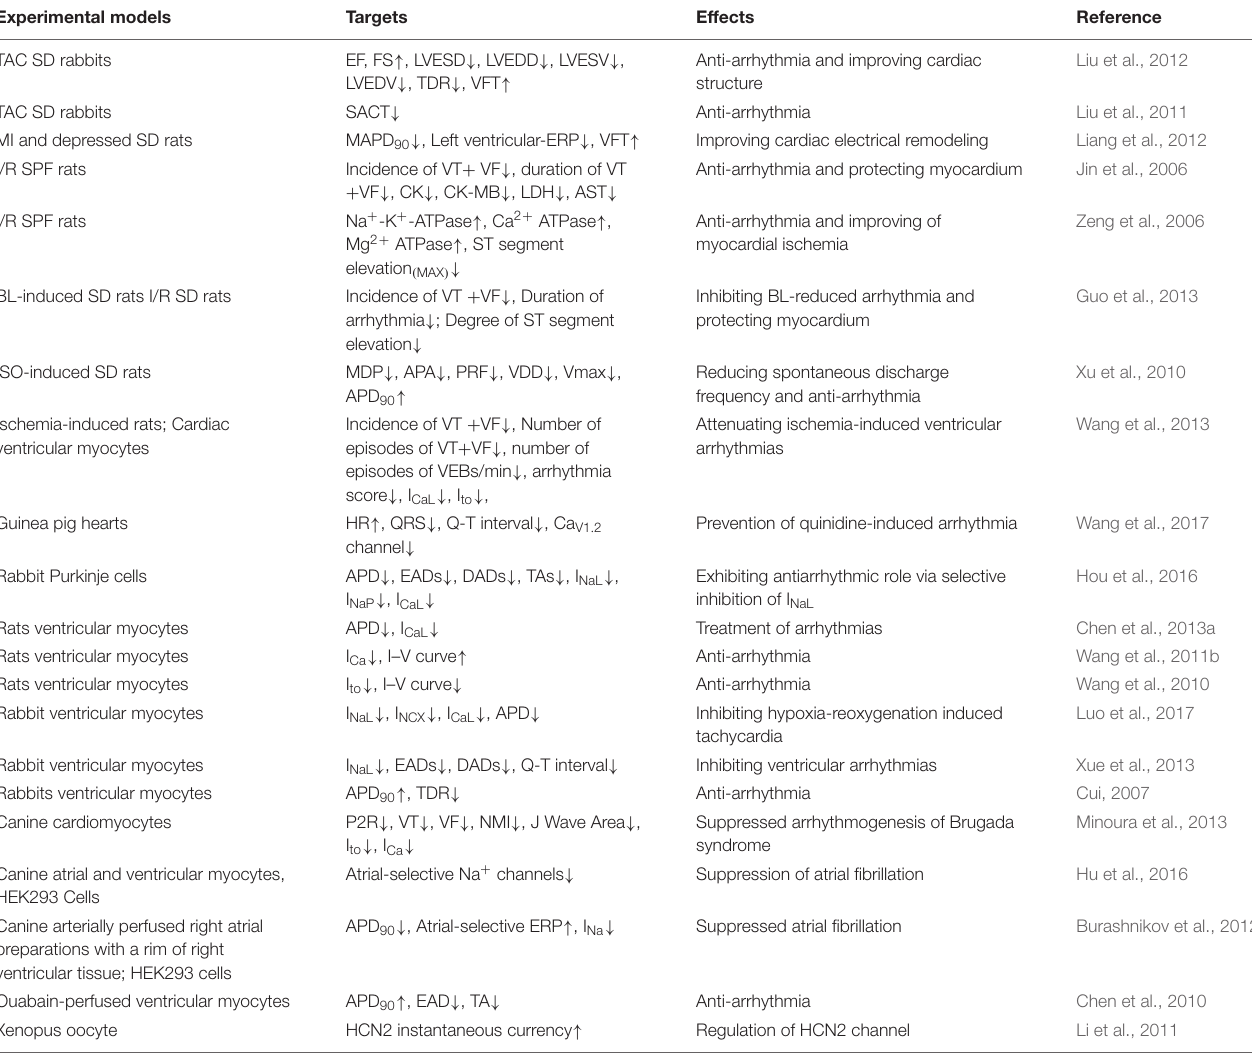
TABLE 2 | The antiarrhythmic effect of WXKL.